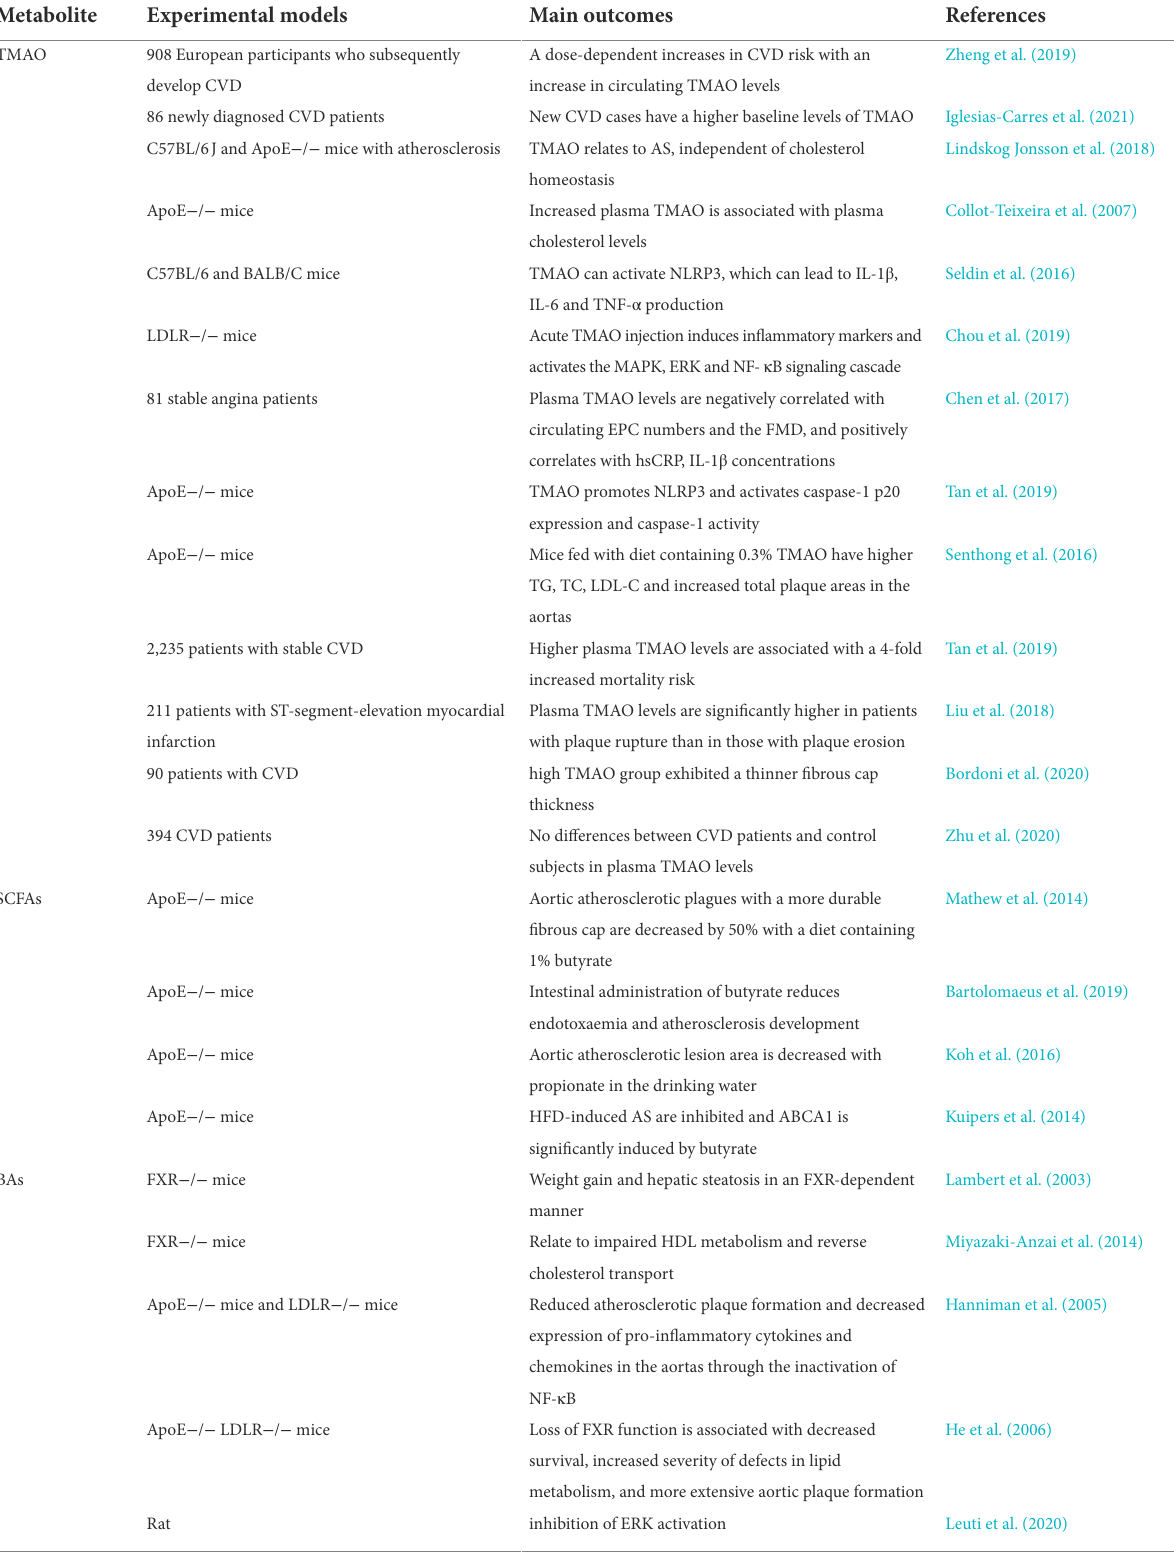
TABLE 1 Gut microbial-derived metabolites and